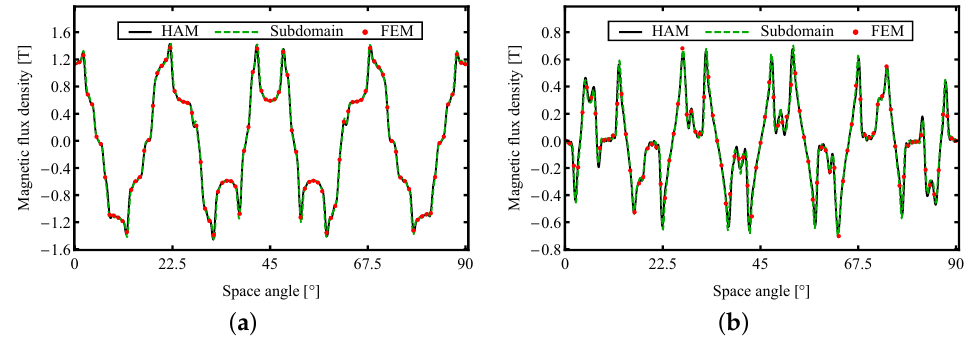
Figure 16. Comparison of the flux density at the middle of the air gap of Machine I with a current of 1 A (maximal amplitude): ( a ) radial component; ( b ) circumferential